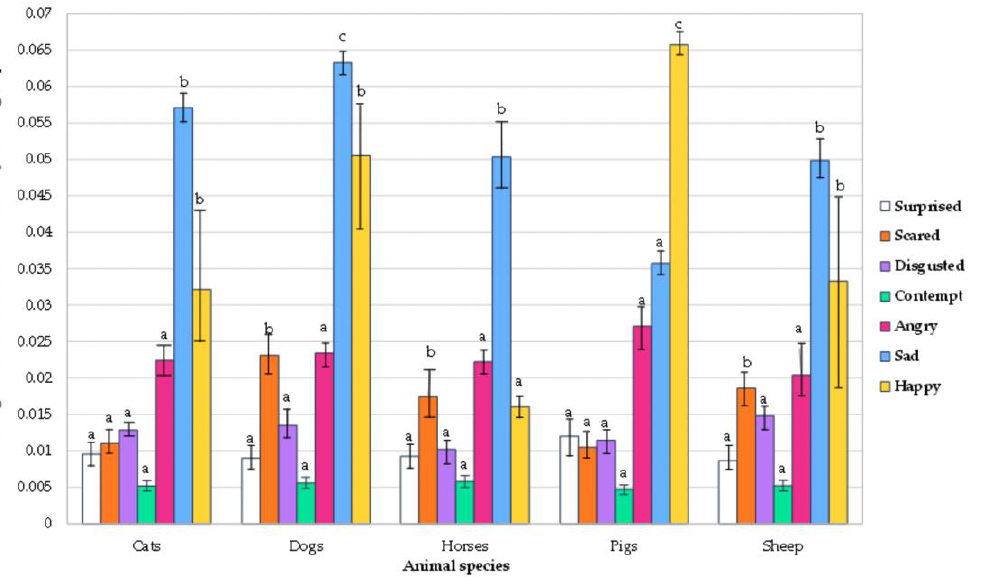
Figure 2. Average values of induced emotions for individuals by different animal species ( a – c : the mean values in the columns of the same color marked with different letters are significantly different ( p ≤ 0.05)).